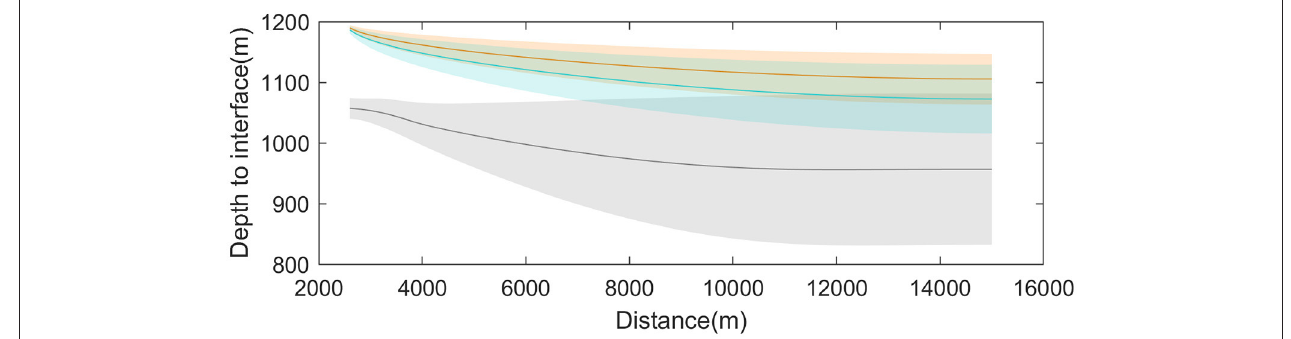
FIGURE 4 | Uncertainty “envelopes” of the simulated interface contours using the VDST model (gray color) the sharp interface model LF1 (orange color) and the sharp interface model LF2 (cyan